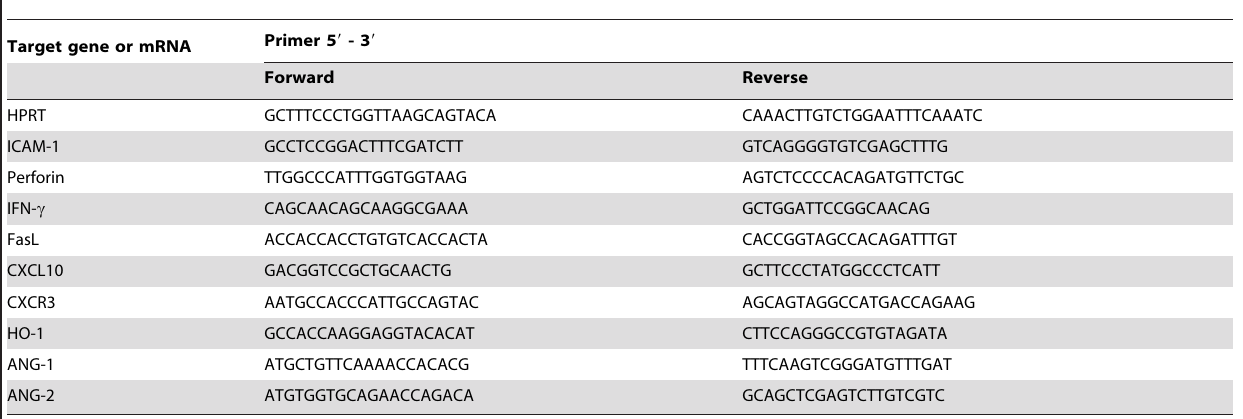
Table 2. Primer sequences